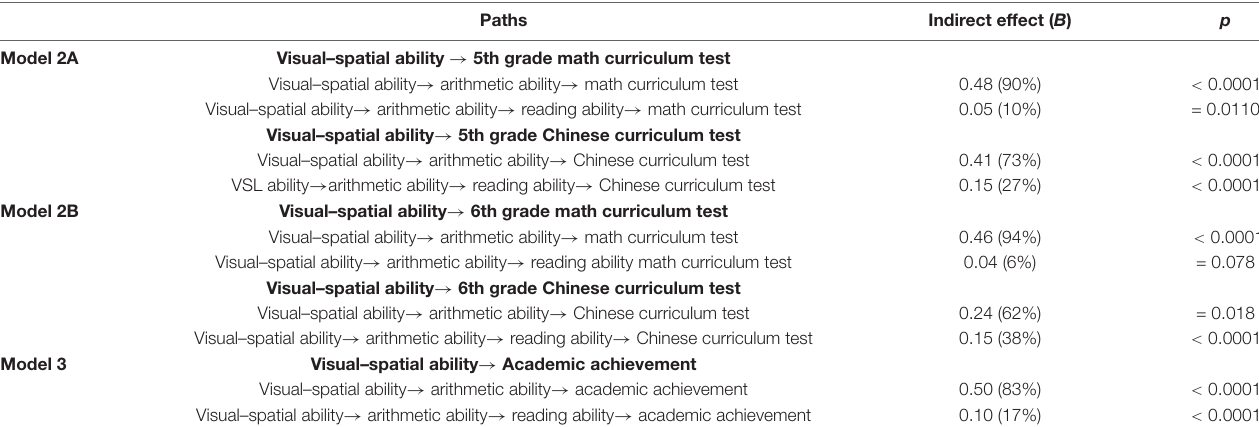
TABLE 4 | Indirect effects from visual–spatial ability to academic